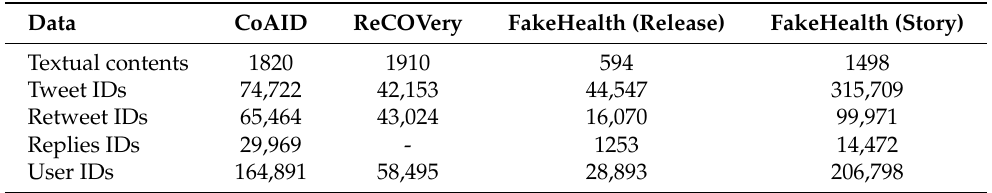
Table 2. Dimensionality of the gathered and cleaned